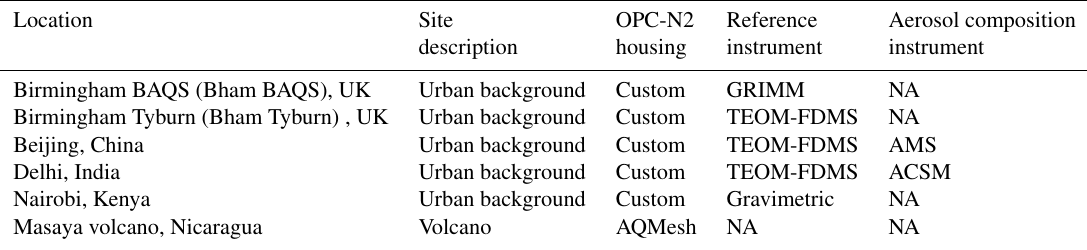
Table 1. Summary of the measurement sites. Full details available in the text. NA signifies not available. Custom housing for the OPC-N2 as per the description in the text. Location Site OPC-N2 Reference Aerosol composition description housing instrument instrument Birmingham BAQS (Bham BAQS), UK Urban background Custom